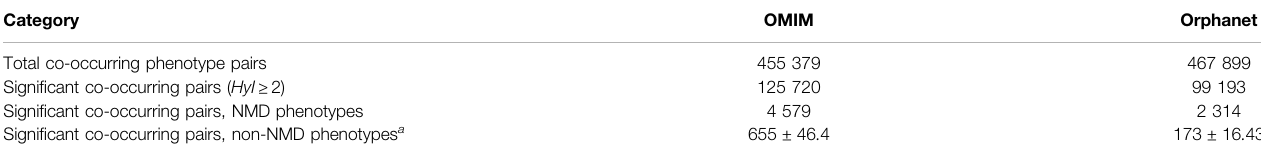
TABLE 3 | Numbers of pairs of co-occurring phenotypes for the OMIM and Orphanet databases. Signi fi cantly co-occurring pairs de fi ned as having a hypergeometric index value ≥ 2.